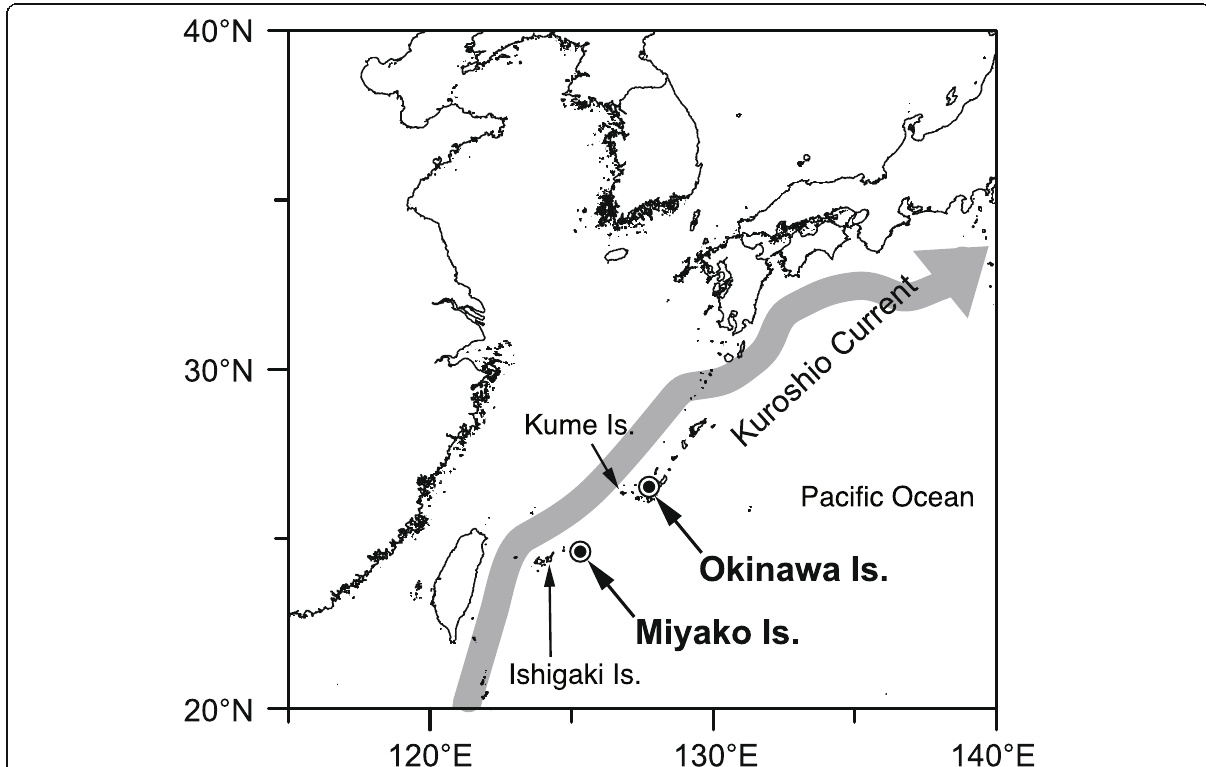
Fig. 1 Map of eastern Asian and the northwestern Pacific regions showing the locations of Miyako Island and Okinawa Island (this study) and Ishigaki Island (Abe et al. 2009; Hirabayashi et al. 2017) and Kume Island (Ohmori et al. 2014) discussed in the